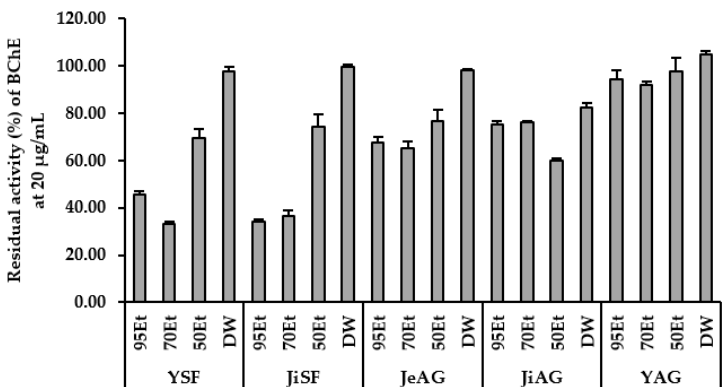
Figure 4. Inhibition of AChE by the extracts. Activity of AChE was observed by Ellman method as described in the ‘Materials and Methods’ section, by adding the extract ( 20 μg/mL ) to the reaction mixture containing ATCI and DTNB (0.5 mM each).